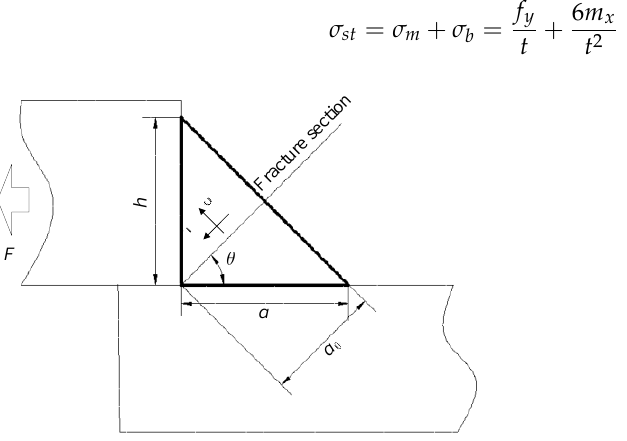
Figure 4. Stress status of fillet weld.